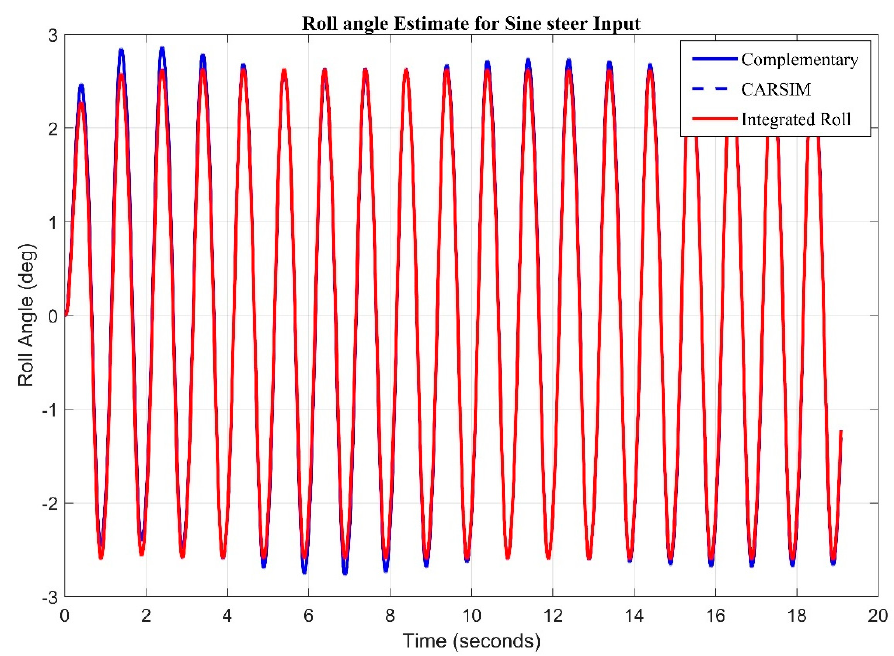
Figure 15. Complementary Filter Response for Sine Input.